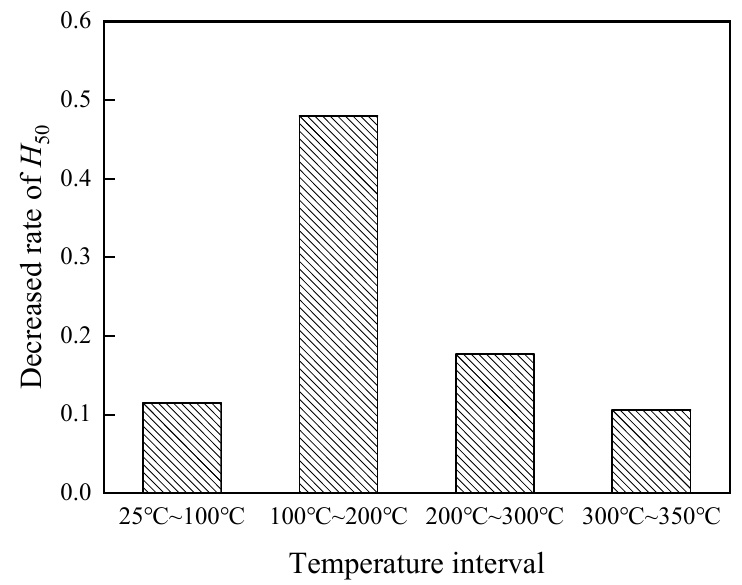
Figure 5. Decreased rate of H 50 at different temperature intervals.